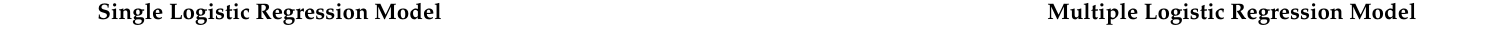
Table 3. Significant influencing factors of hospital stays longer than 6 days for patients with community-acquired infections based on single and multiple logistic regression